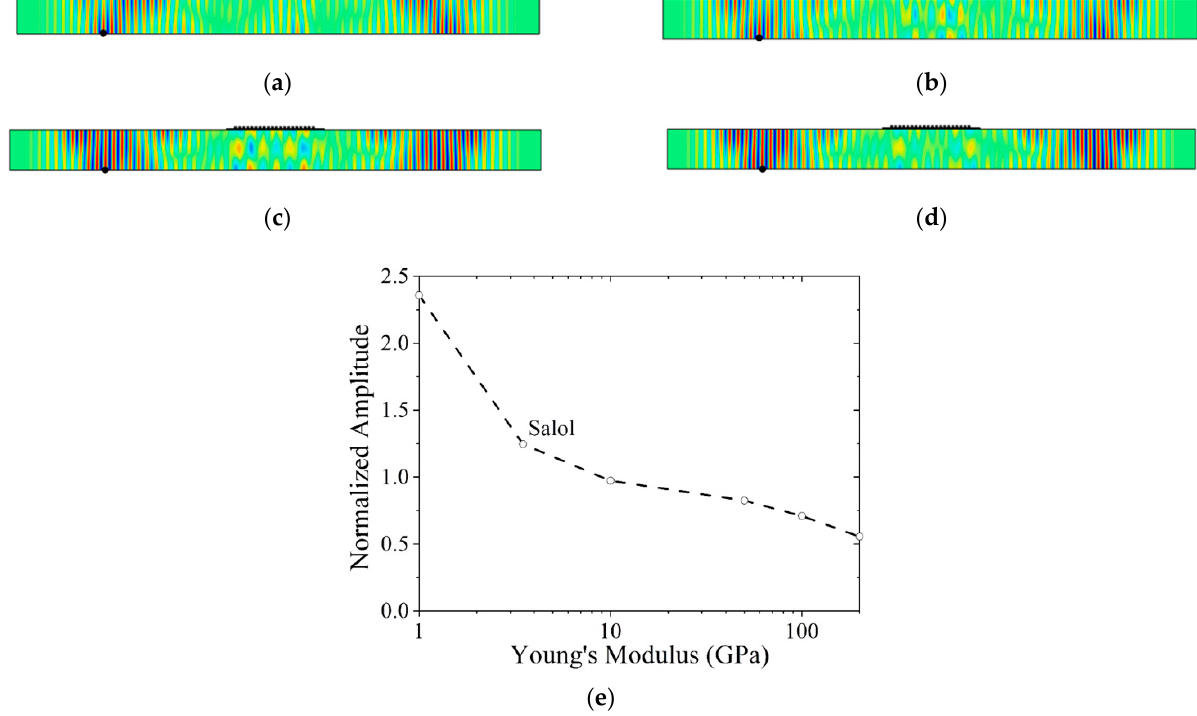
Figure 8. Normalized SH0 wave amplitude as a function of adhesive Young’s modulus. u 2 distribution at 50 μ s for: ( a ) E = 1 GPa; ( b ) E = 3.49 GPa; ( c ) E = 10 GPa; ( d ) E = 50 GPa; and ( e ) normalized SH0 wave amplitude as a function of adhesive Young’s modulus. Point marker in each plot ( a – d ) indicates the place where the maximum u 2 displacement occurs.